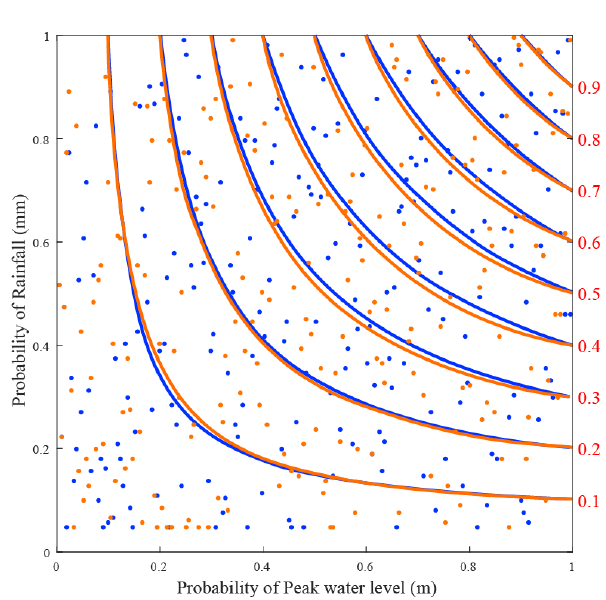
Figure 5. With RSLR (red) and without RSLR (blue) for two differ- ent copulas. Both the peak water level ( x axis) and the accumulated rainfall ( y axis) are presented in probability space. The red isolines are the fitted Gaussian copula and the blue lines use a Clayton cop- ula. The lines are copula isolines and the dots show observed data. The vertical axis on the right-hand side shows the joint probability values of the isolines.